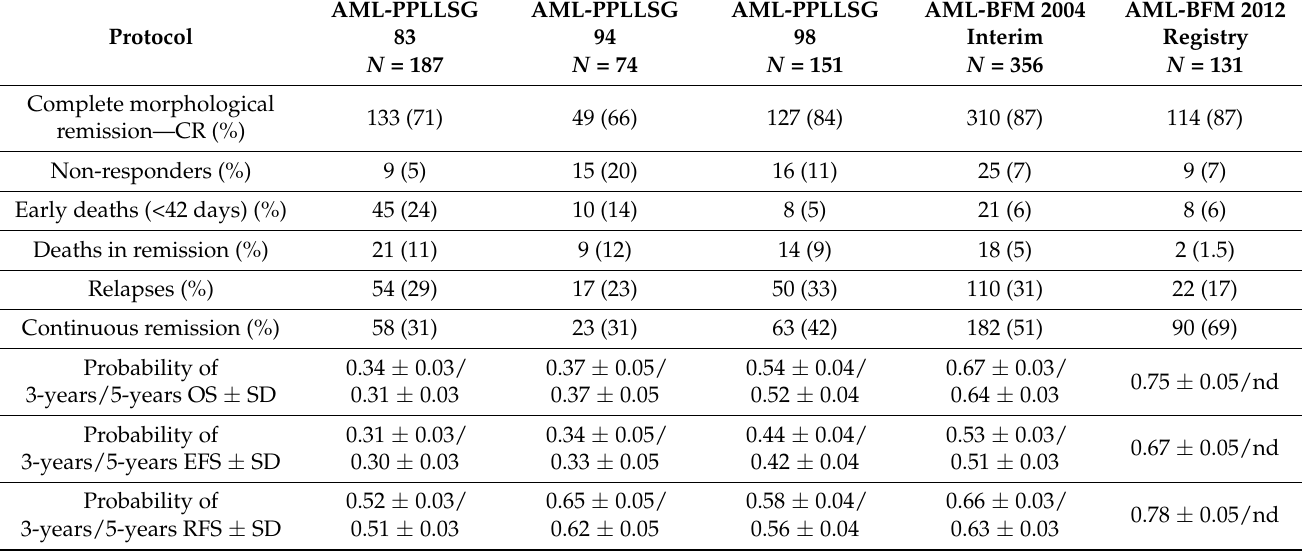
year OS increased from 0.34 ± 0.03 to 0.75 ± 0.05, EFS from 0.31 ± 0.03 to 0.67 ± 0.05, and RFS from 0.52 ± 0.03 to 0.78 ± 0.05. The survival curves are presented in Figure 3, and the probabilities of survival are in Table